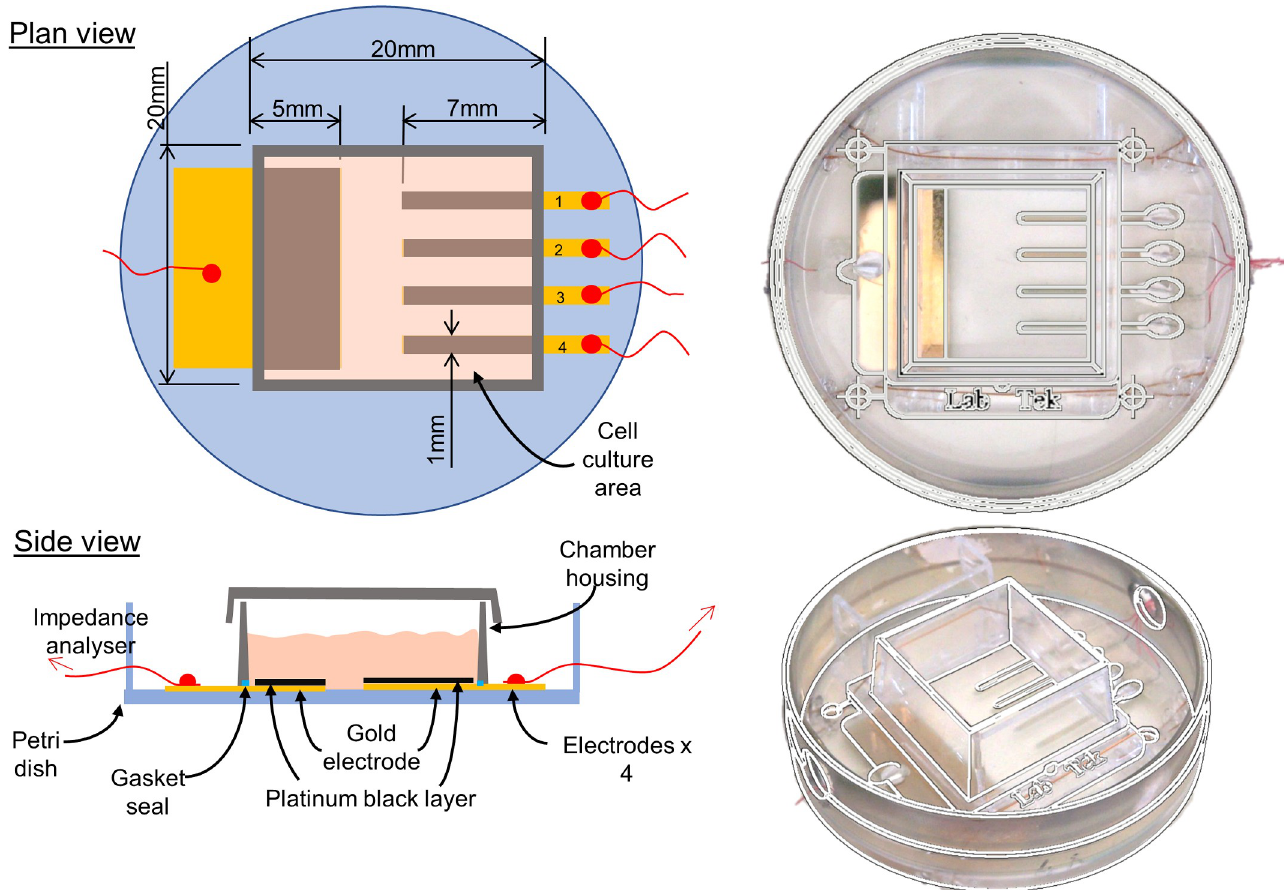
Fig 1. Chamber design with cell culture surface and electrode